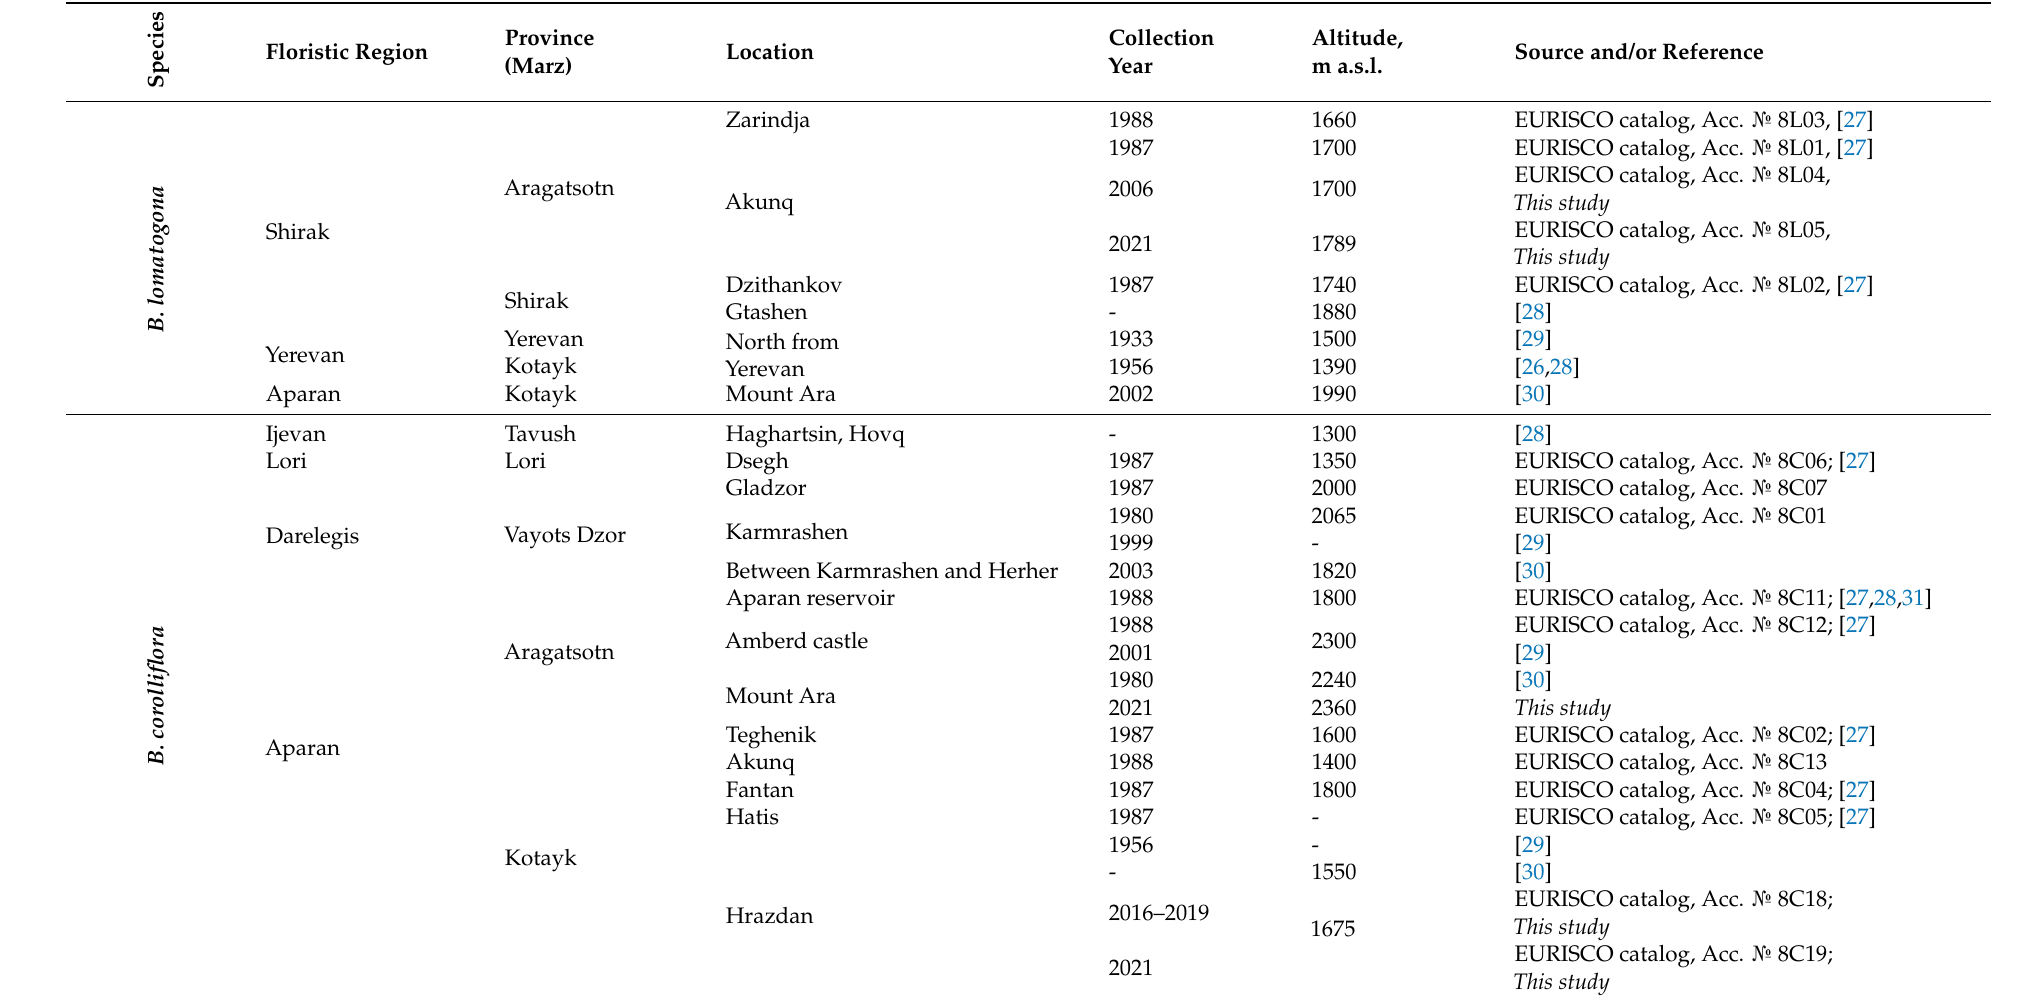
Table 1. Wild species of beet reported in Armenia. The table summarizes records of the wild beet species in Armenia, including information from the fieldworks of our group, accessible databases, catalogs, and published